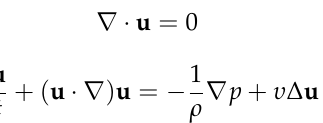
Table 1. Dimensionless parameters of the crucian carp model.